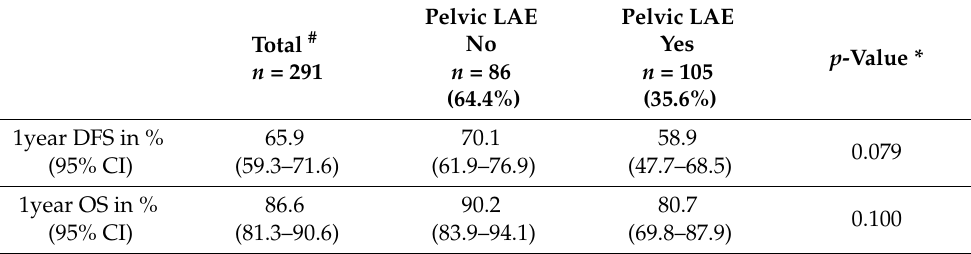
Table 7. Prognosis with regard to surgical approach.